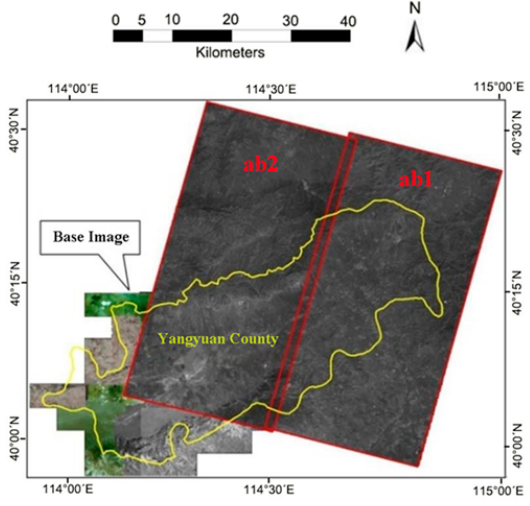
Figure 4. The improved rectification images ab1/ab2.